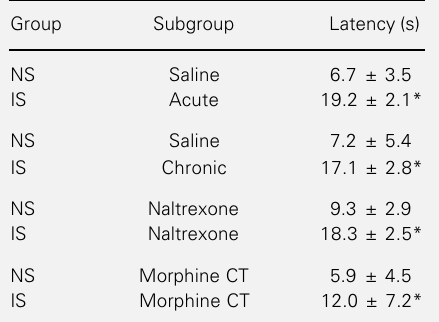
Table 1 - Antinociception is not blocked by naltrexone. The numbers indicate the mean tail-flick latency (– SD in s) observed soon after the training ses- sion. IS indicates rats receiving inescapable shocks and NS, non-shocked rats. Prior to train- ing, the rats received either 0.9% saline (acutely or chronically), or naltrexone (8 mg/kg) or were made cross-tolerant (CT) to morphine (10 mg/kg). *P £ 0.05 compared to the NS control group (Dunn(cid:146)s test). N = 8 rats per